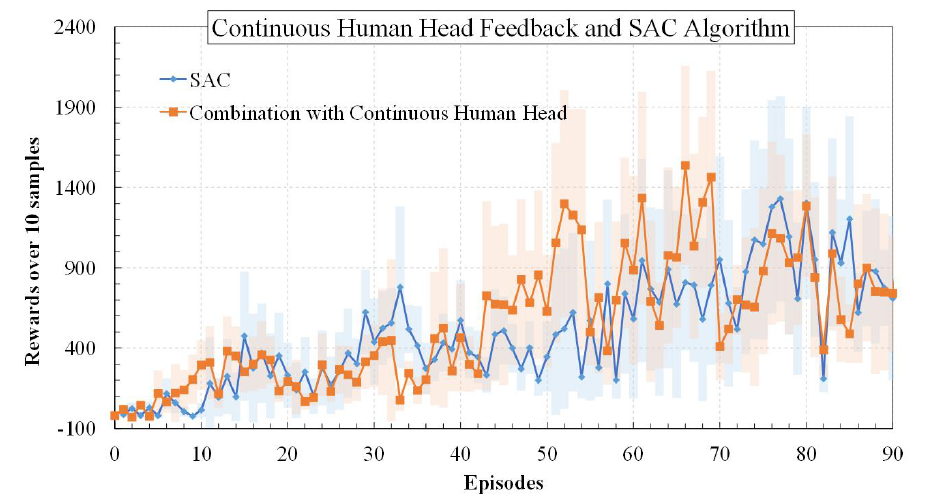
Figure 5. A comparison of baseline SAC with a proposed method engaged with human continuous feedback from the head averaged over 10 samples.